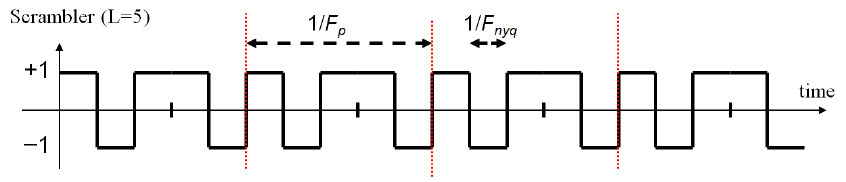
Figure 2. Illustration of the scrambling signal.